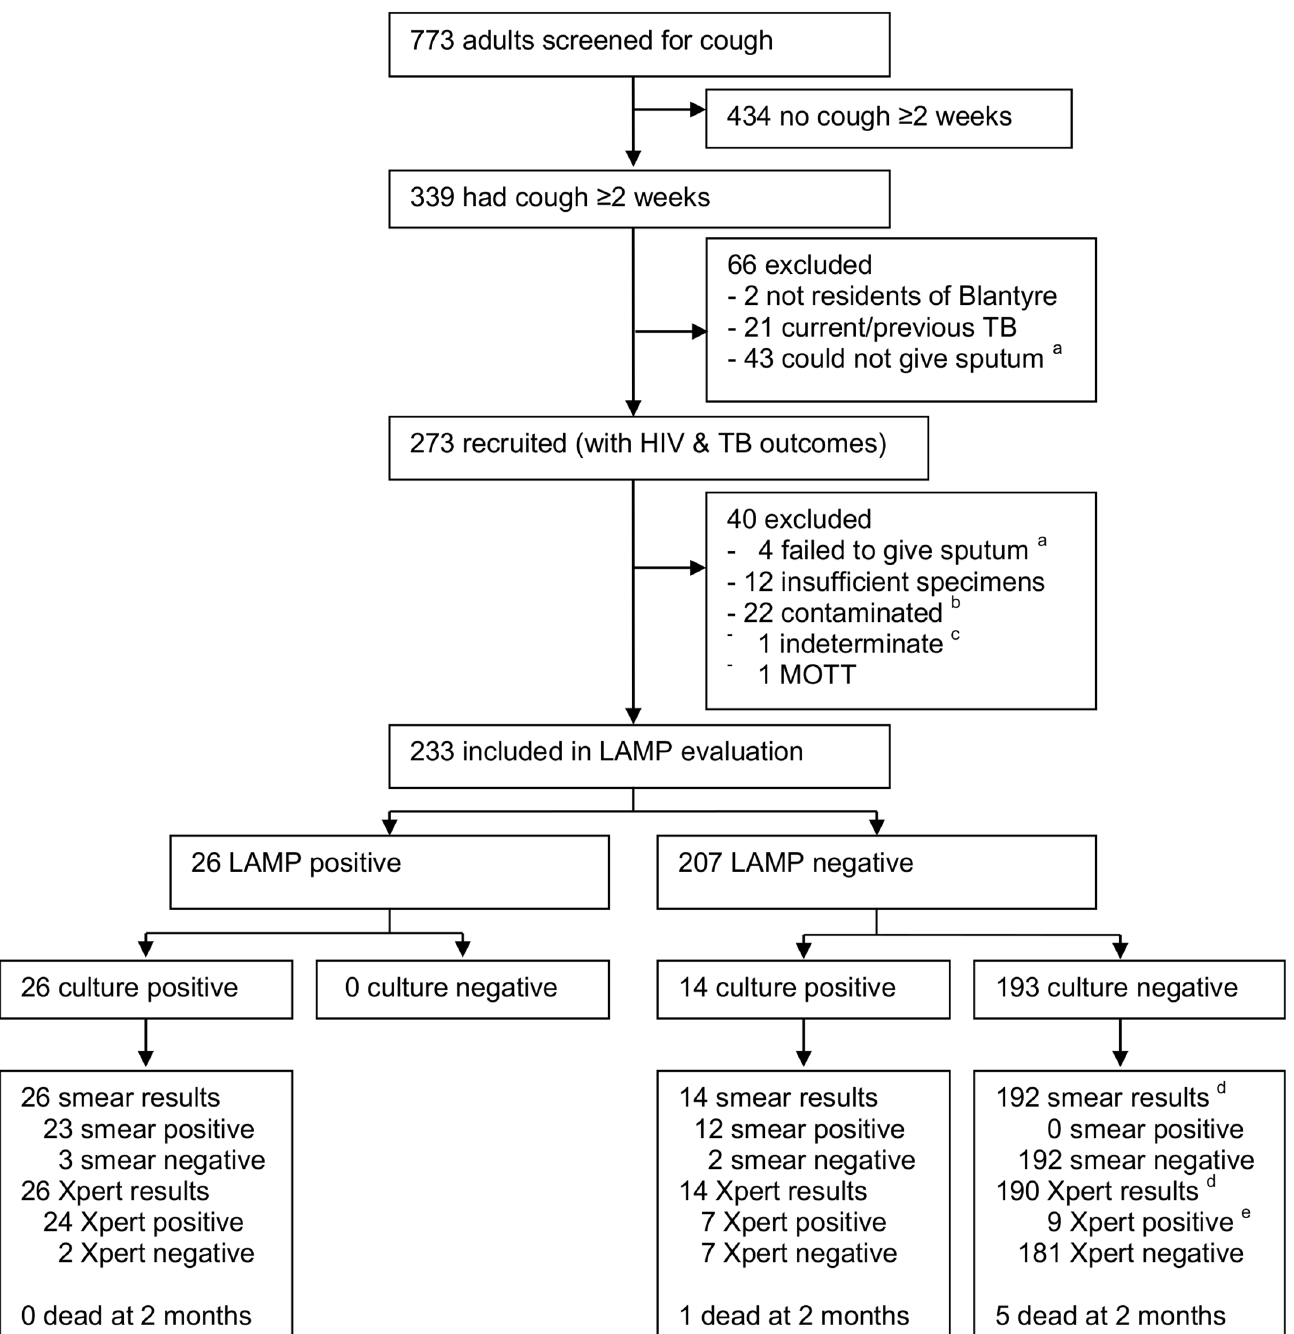
Fig 2. Recruitment of participants and distribution of TB diagnosis results. Abbreviations: MOTT = Mycobacteria other than tuberculosis; Xpert = Xpert MTB/RIF. a Participants could not give sputum despite having cough (cid:1) 2 weeks. b All contaminated samples were smear negative. c indeterminate result if culture negative and smear positive. d Missing results: 1 fluorescence smear result and 3 Xpert MTB/Rif result. e participants with culture- and smear- negative results had ‘ MTB detected low ’ results on Xpert 1 MTB/RIF.